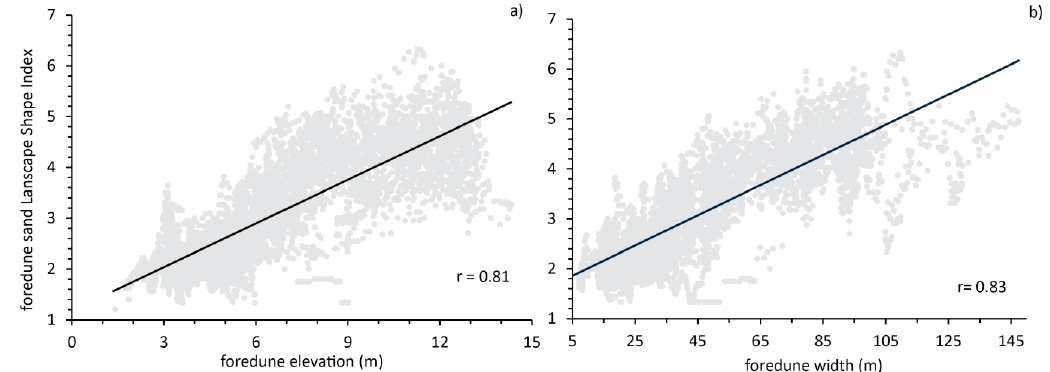
Figure 11. Foredune sand landscape shape index vs. ( a ) foredune elevation and ( b ) foredune width. It is not possible to define a critical threshold [32,35] where, for example, small changes in the sand LSI in values are related to abrupt changes in the morphology, determining changes in the environmental patterns. The foredune sand LSI is, in fact, also inversely related for long parts of the coast, with the sand cover percentage that shows higher values in the northern part of the stretch, while the LSI has higher values in the southern part (Figure 12). This means that in the south, the sand cover is both reduced and discontinuous.